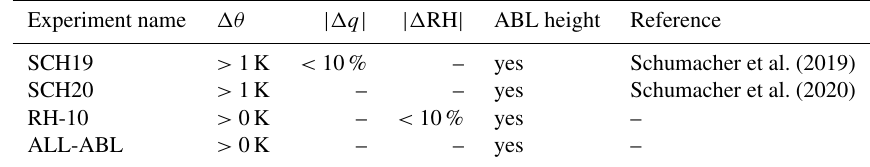
Table 2. Overview of detection criteria for sensible